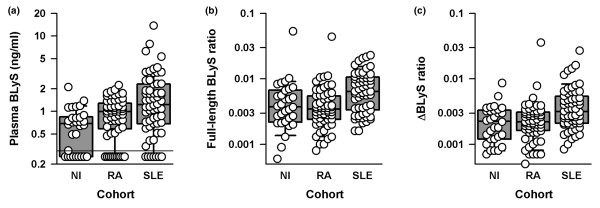
BLyS protein and BLyS isoform mRNA levels in normal individuals, and RA, and SLE patients. (a) Plasma from normal individuals (Nl), and RA and SLE patients were assayed for BLyS levels by ELISA. Each symbol indicates an individual subject. The composite results are plotted as box plots. The lines inside the boxes indicate the medians, the outer borders of the boxes indicate the 25th and 75th percentiles, and the bars extending from the boxes indicate the 10th and 90th percentiles. The thin solid line across the plot indicates the lower limit of detection in the BLyS assay (0.3 ng/ml). (b,c) RNA was extracted from peripheral blood buffy coats from the same individuals. Amounts of full-length BLyS, ΔBLyS, and actin mRNA were quantified by real-time RT-PCR, and results are shown as ratios of full-length BLyS mRNA (b) and ΔBLyS mRNA (c) to actin mRNA. BLyS, B lymphocyte stimulator; ELISA, enzyme-linked immunosorbent assay; RA, rheumatoid arthritis; RT-PCR, reverse transcription polymerase chain reaction; SLE, systemic lupus erythematosus.